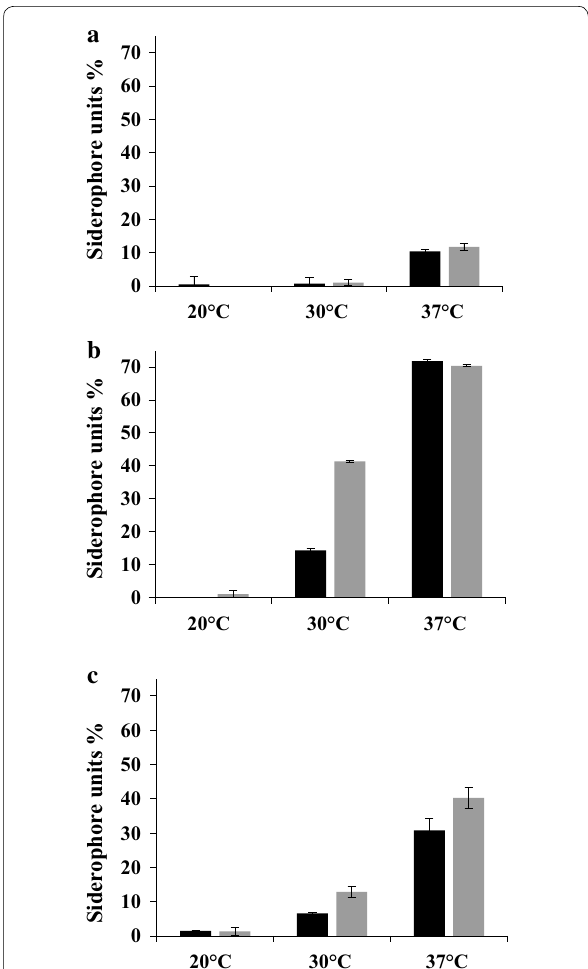
Fig. 6 Quantification of siderophore in Staphylococcus aureu s culture supernatants. Cell cultures were grown at 20, 30 and 37 °C, during 24 h (black square) and 48 h (grey square). Planktonic cells ( a ), biofilm grown on polycarbonate ( b ), biofilm grown on stainless steel ( c